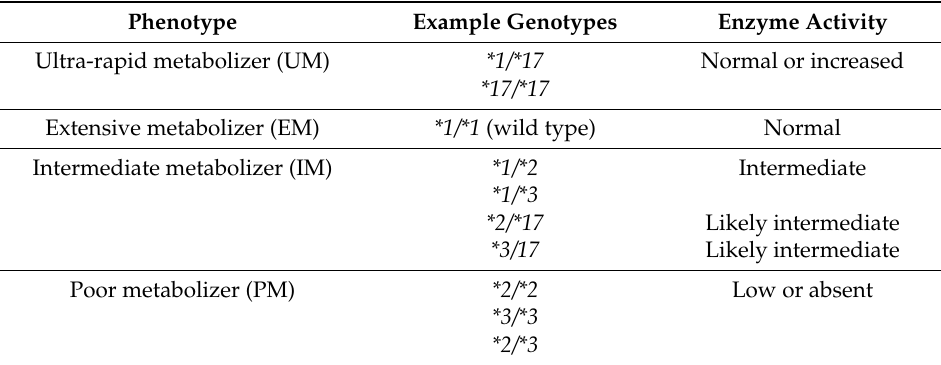
Table 2. Assignment of likely CYP2C19 phenotypes based on genotypes. Adapted from [68], used with permission of John Wiley and Sons; copyright